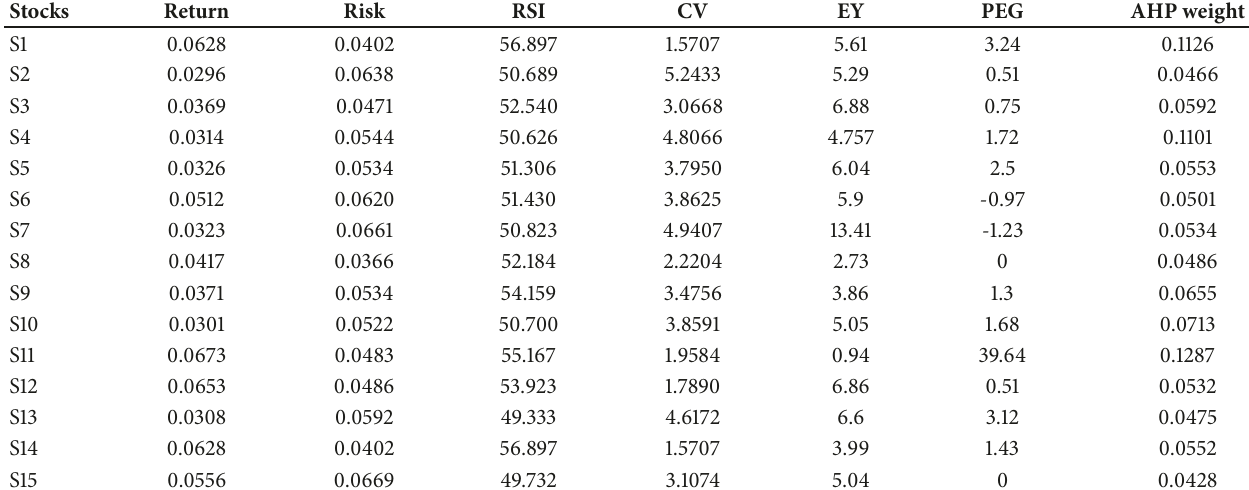
Table 4: Input data for Cluster 1.